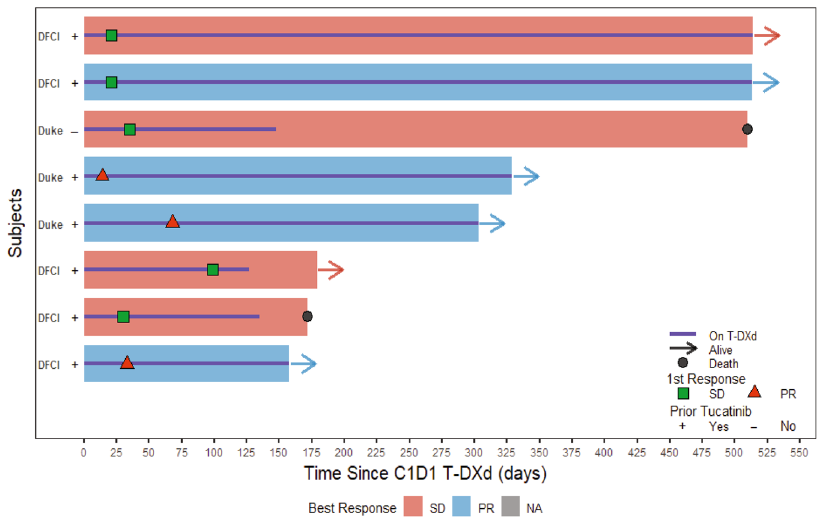
Fig. 2 Overall survival and time on T-DXd in a series of 8 patients with breast cancer HER2 + leptomeningeal metastases. Swimmers plot depicting time on treatment, best response by formal neuroradiology review and overall survival in patients with HER2 + LM treated with T-DXd.